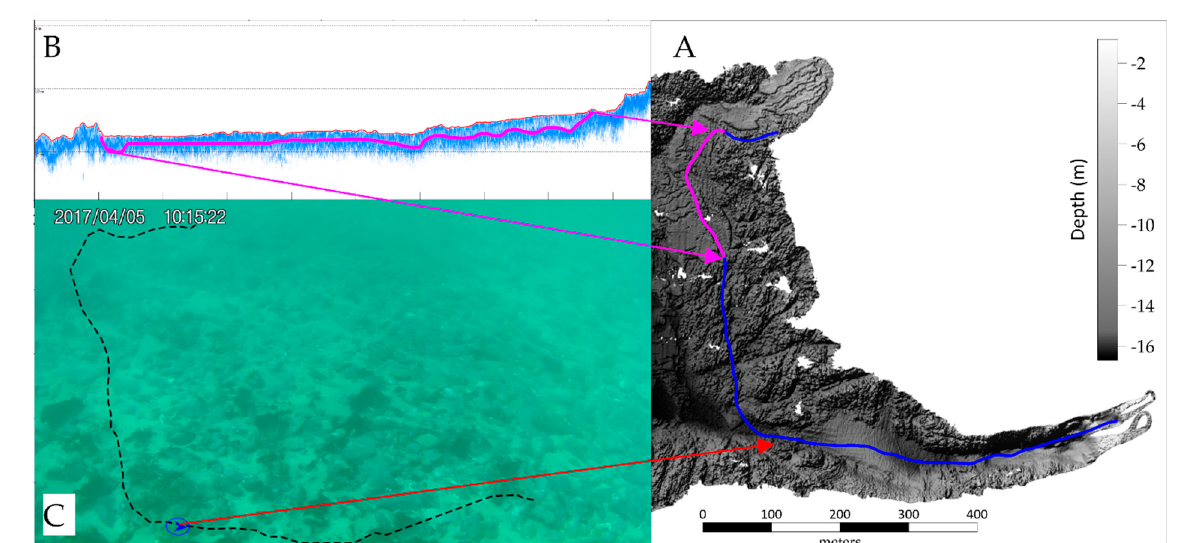
Figure 6. Acoustic slices/profiles of the survey region. The bedrock underneath the sandy substrate being a kriging inter- polation of the sub-bottom acoustic reflector data.